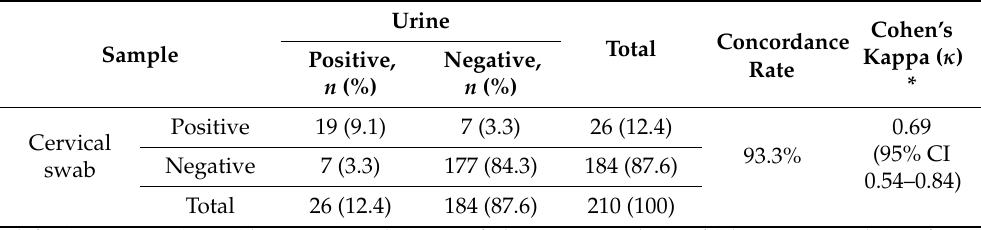
Table 1. Comparison of HPV detection rates in cervical swabs and random urine samples from 210